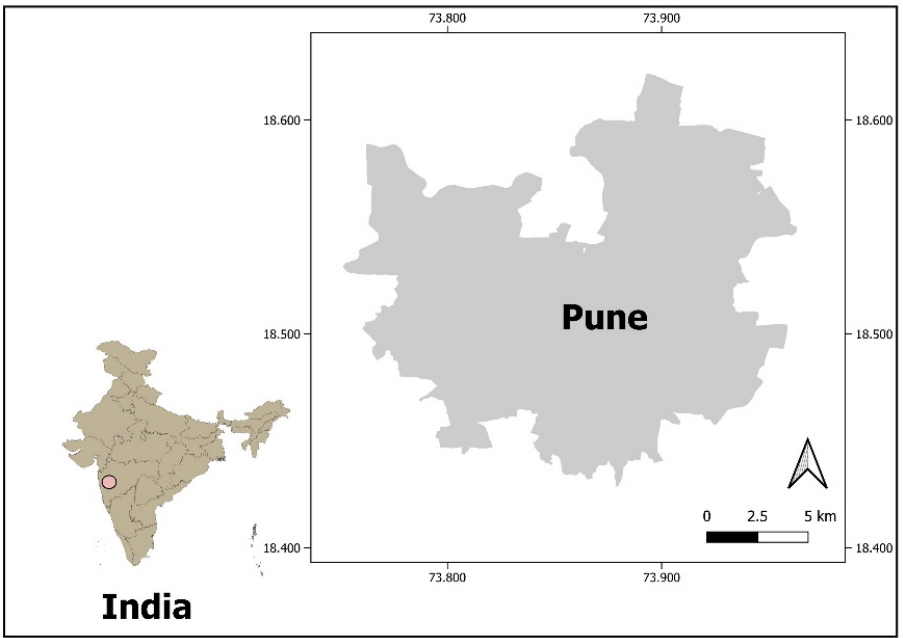
Figure 1. Location map of Pune.